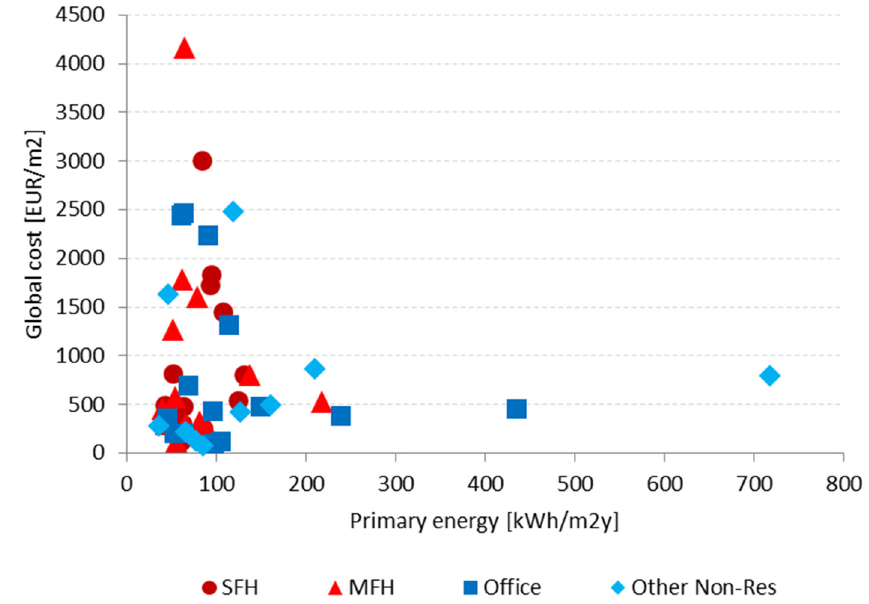
Buildings 2022 , 12 , x FOR PEER REVIEW Figure 7. Cost-optimal levels for new buildings. Figure 7. Cost-optimal levels for new buildings.